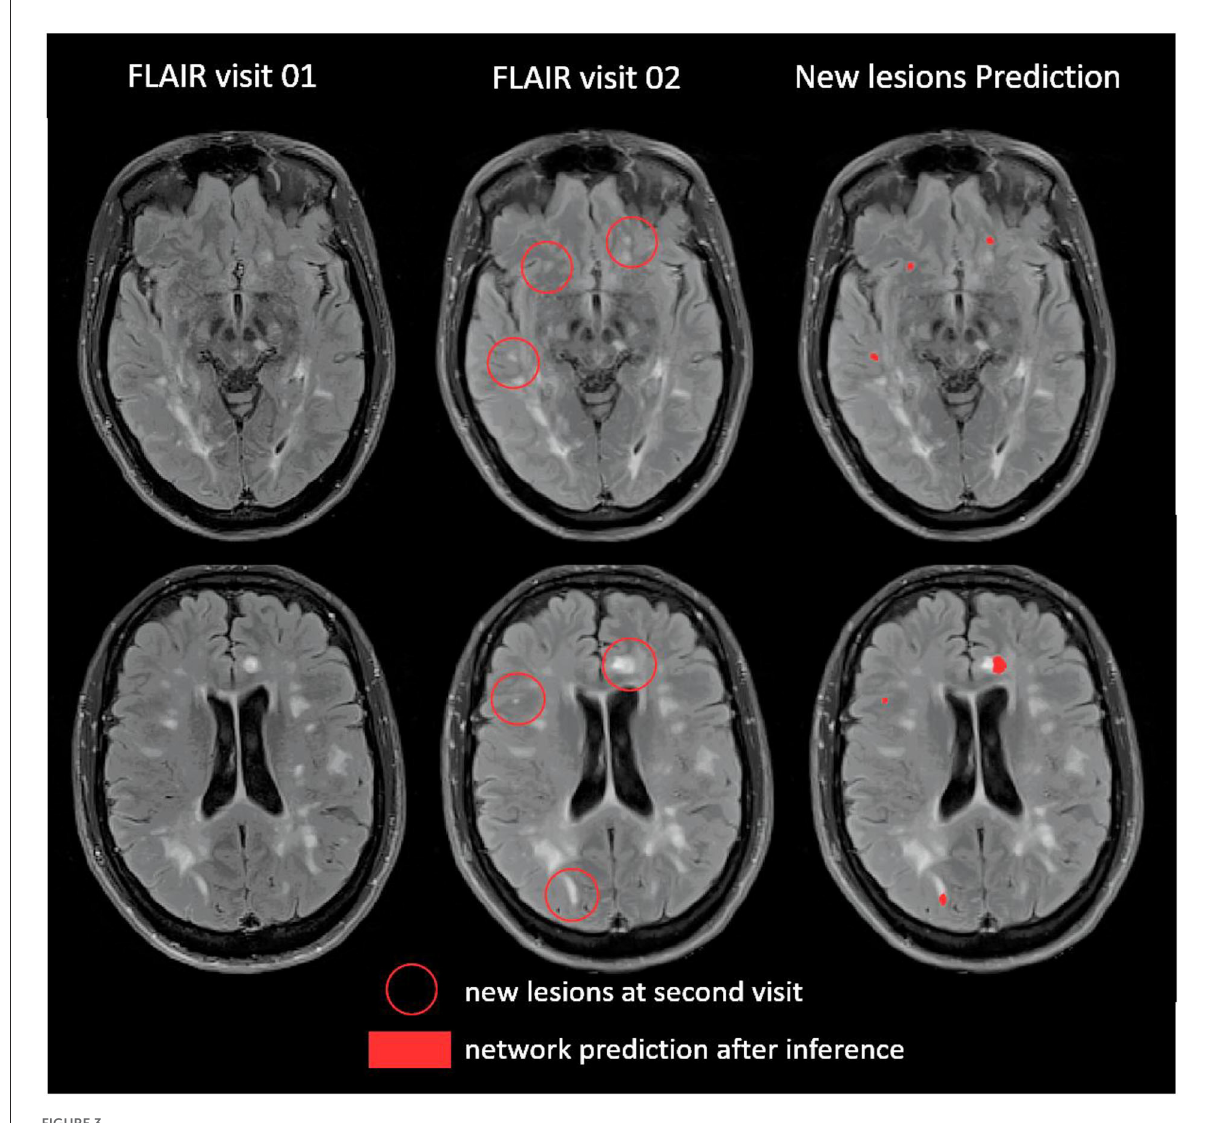
FIGURE3 Example of prediction on one patient from our second testing dataset (Bodini et al.,